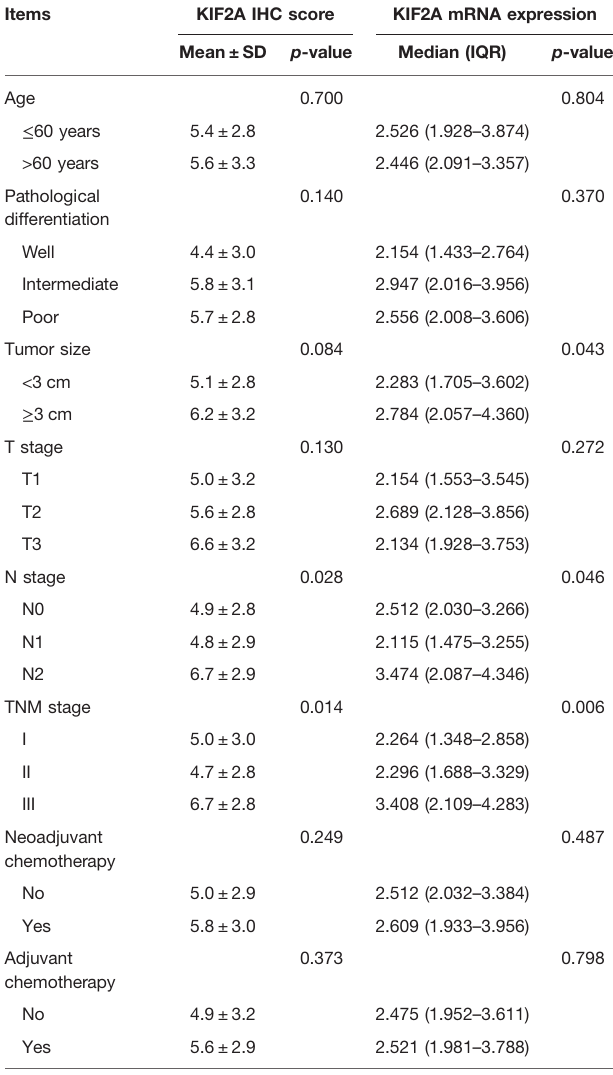
TABLE 2 | Correlation of tumor KIF2A expression with clinical